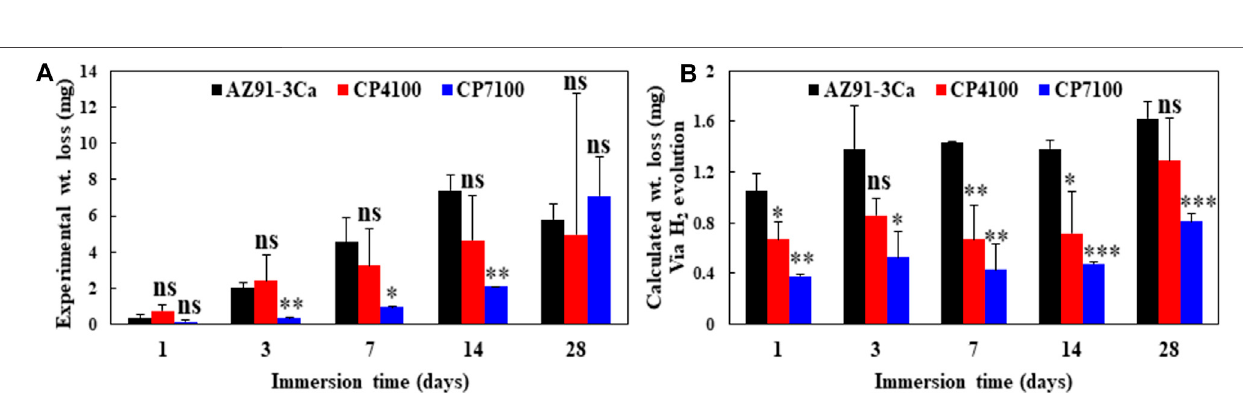
Frontiers in Materials |